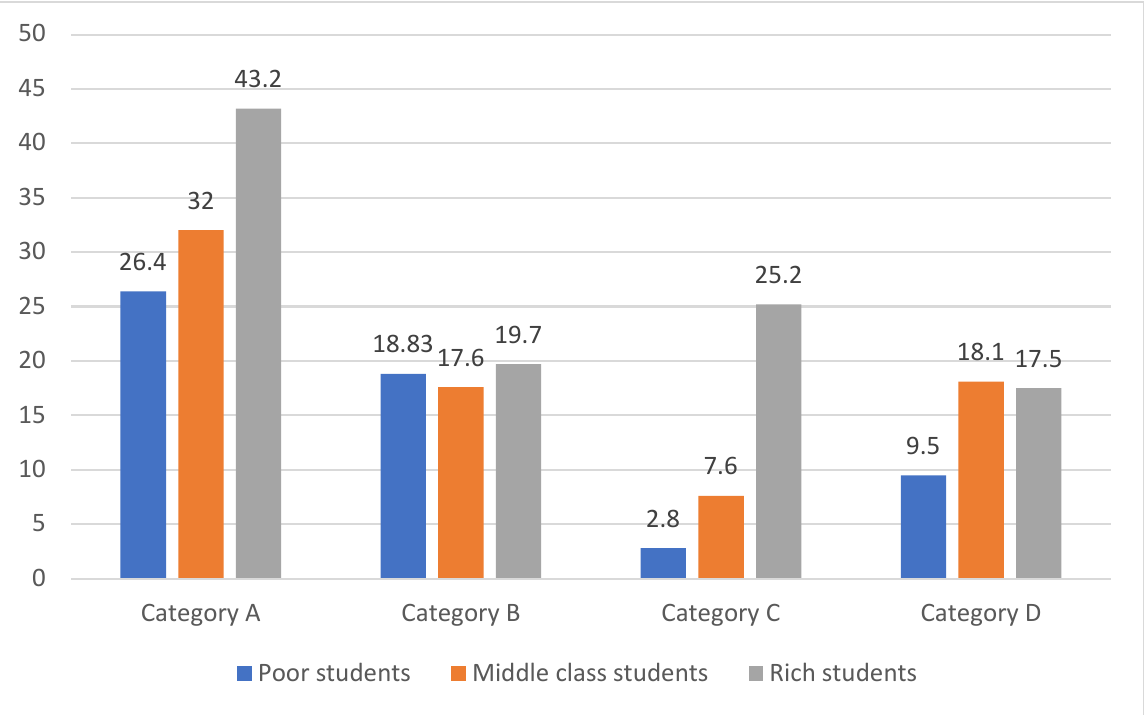
Figure 3. Category A, B, C, and D of F model for poor, middle-class, and rich students.